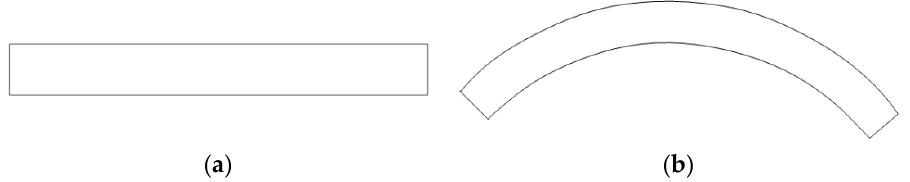
Figure 21. The extraction of boundaries for the straight ramp and the curved ramp: ( a ) straight ramp and ( b ) curved ramp.